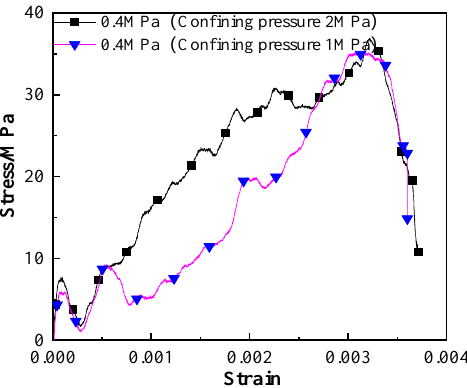
Figure 15. Dynamic stress–strain curve of active confining pressure of sandstone-like material. Table 6. Experimental results of active confining pressure impact of sandstone-like materials.